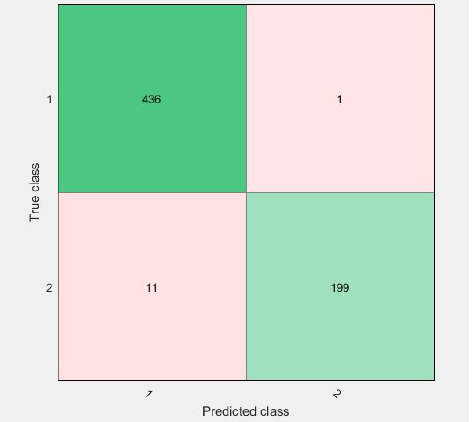
Figure 9. Confusion matrix of parallel fusion using 10-fold classification with LSVM.